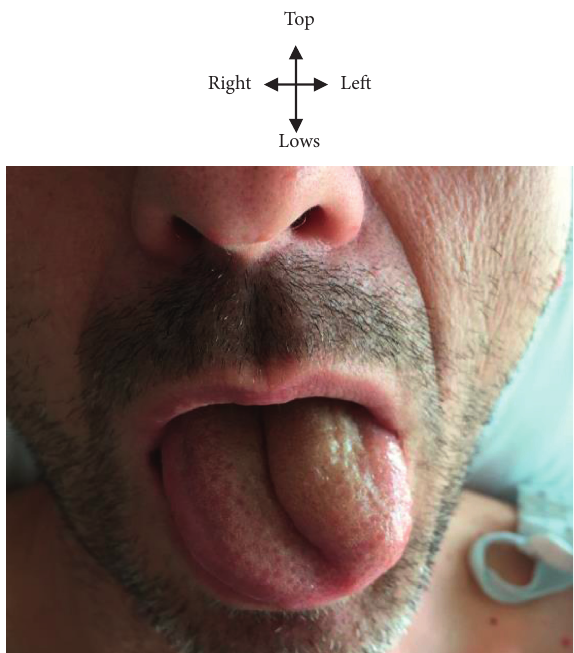
Figure 3: Left ipsilateral deviation of the tongue to protraction (arrow) in Mr. C.E. suggestive of a left carotid